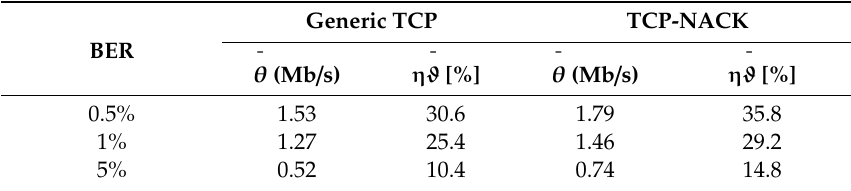
Table 6. Emulated link results.